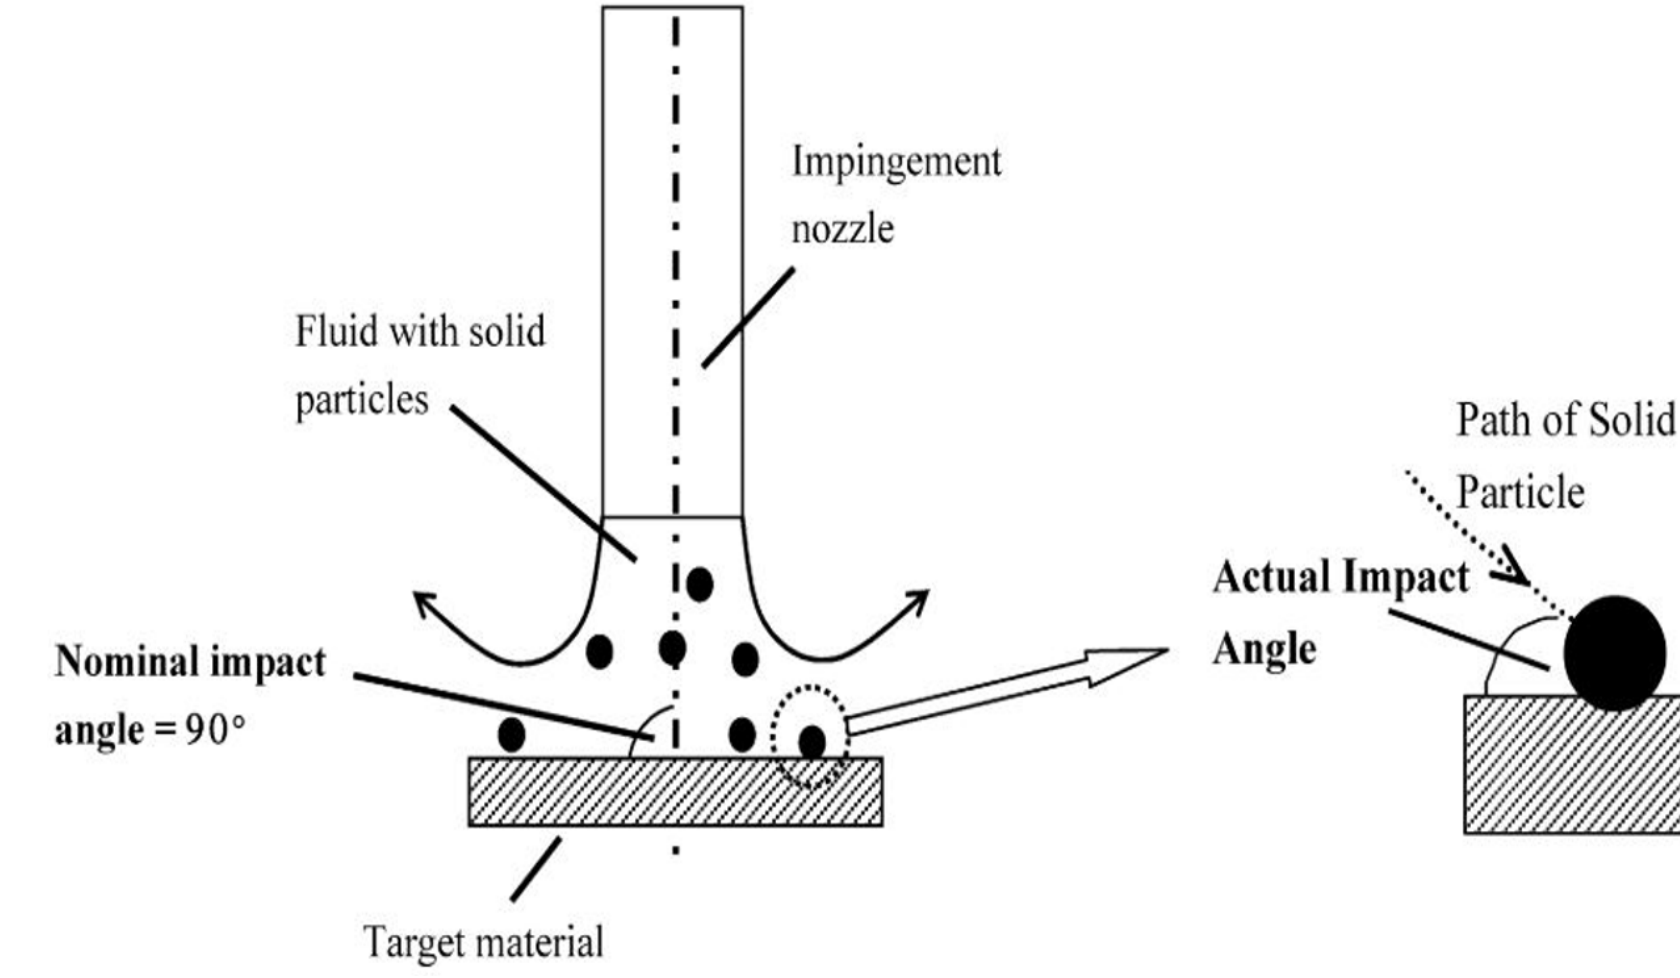
Figure 2. Actual and nominal impact angles are compared for solid particles